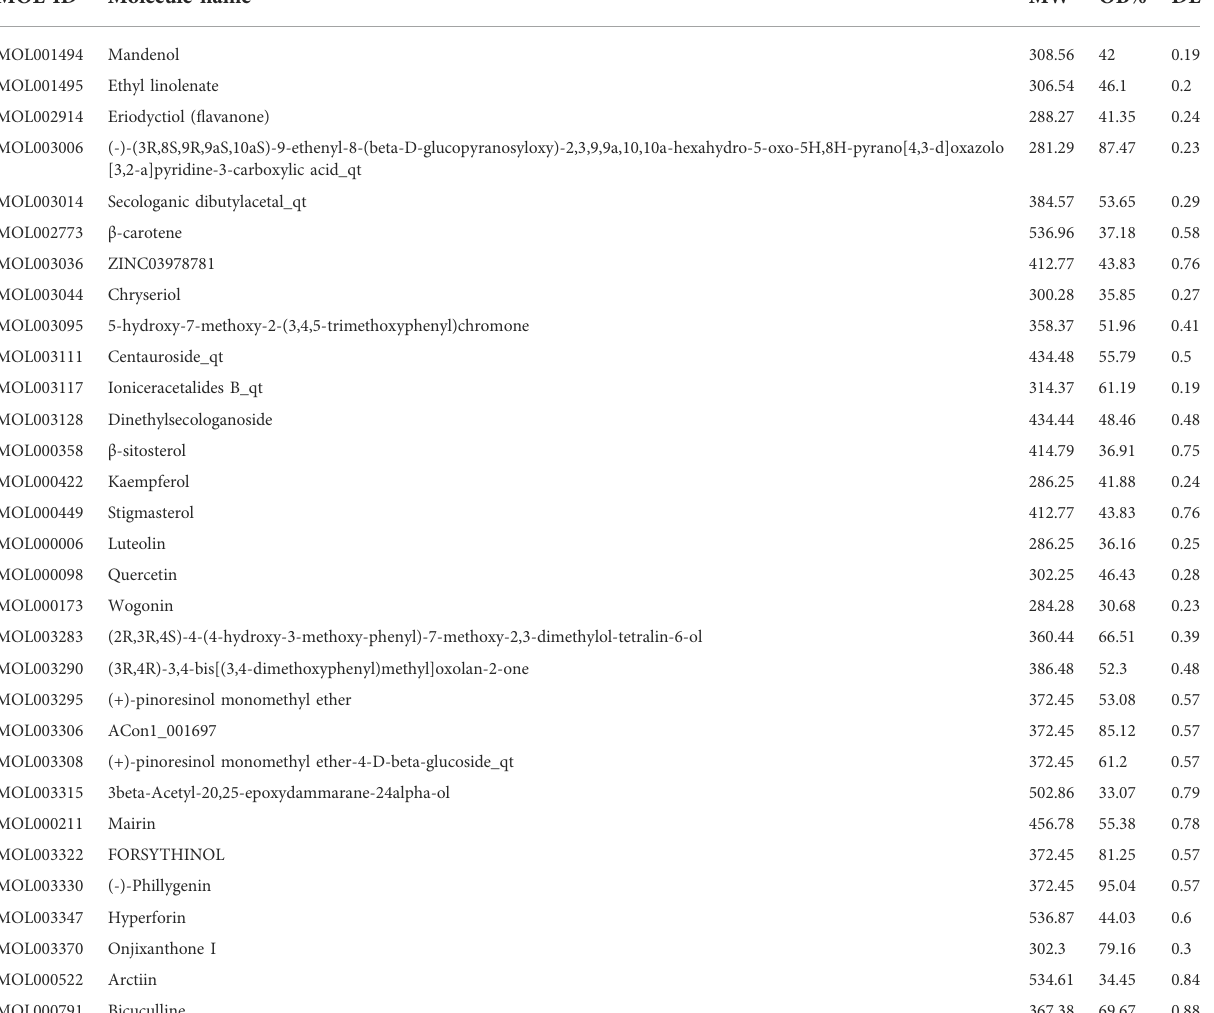
TABLE 3 The active components of